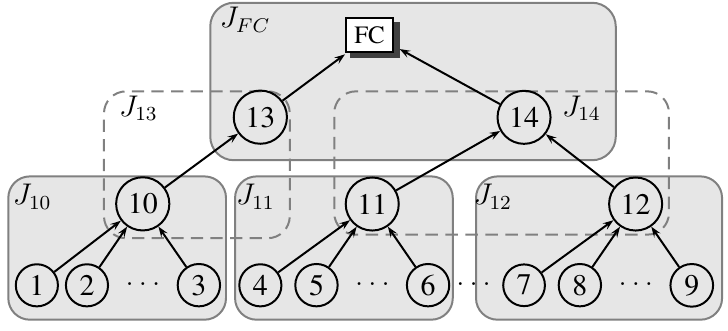
Figure 7. Hierarchical optimization for the transmission control policy (XCP) design problem.